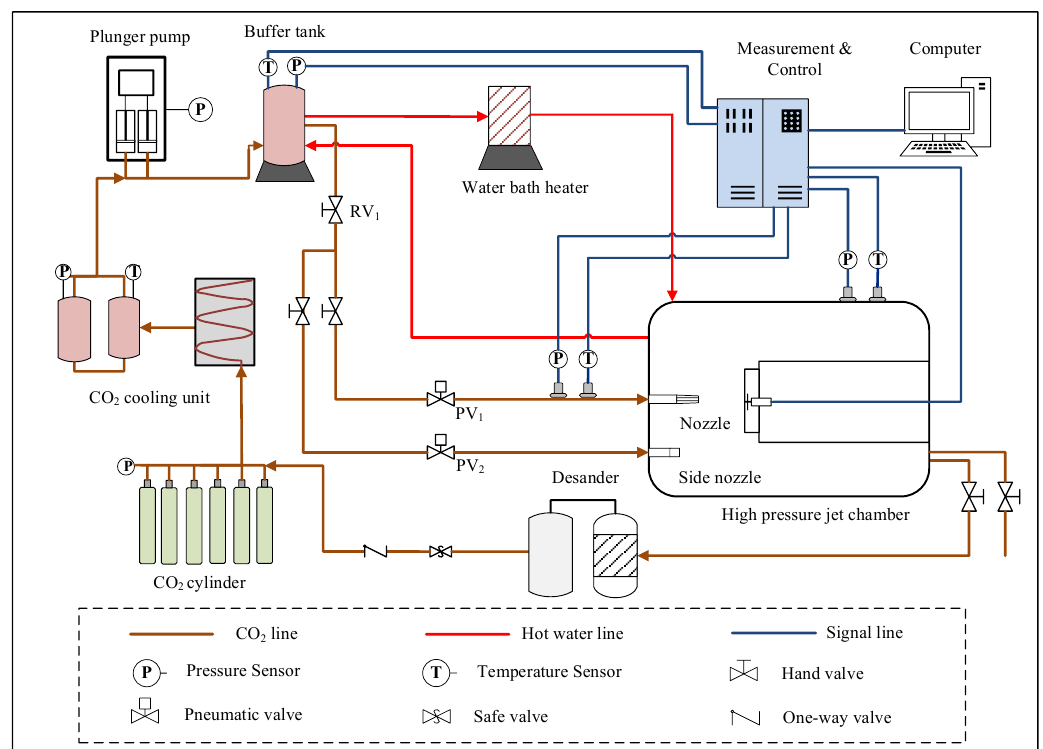
Figure 1. Schematic diagram of experimental setup. The schematic diagram of the organ-pipe nozzle used in the experiments is shown in Figure 3. Based on previous research on the self-excited oscillating jet produced by the organ tube nozzle [37,38], preliminary experiments were carried out to determine the optimal chamber length range suitable for the experimental conditions in this study to produce strong impact pressure oscillations. Seven nozzles were tested with different oscillation chamber lengths (i.e., L c = 7.5, 9, 10.5, 12, 13.5, 15, and 16.5 mm), and other structure parameters are summarized in Table 2. Cylindrical red sandstone specimens with a diameter of 50 mm and a length of 100 mm were prepared for the rock erosion tests. The mechanical properties of the rock specimens were measured by uniaxial compressive strength tests and Brazil split tests, and the specific mechanical parameters are shown in Table 3. The sandstone specimen held by the specimen clamping device was placed at a spacing of 9 mm from the nozzle outlet in the rock erosion tests, and the SEOSJ exiting from the organ-pipe nozzle impinged perpendicularly on the specimen eroding surface. In order to avoid the errors caused by the heterogeneity of local physical and mechanical properties of sandstone, three groups of rock erosion tests were repeated under each working condition, and the average value of each index was taken as the final test value. Carbon dioxide with a purity of 99.99% was used in the experiments. The experimental conditions are summarized in Table